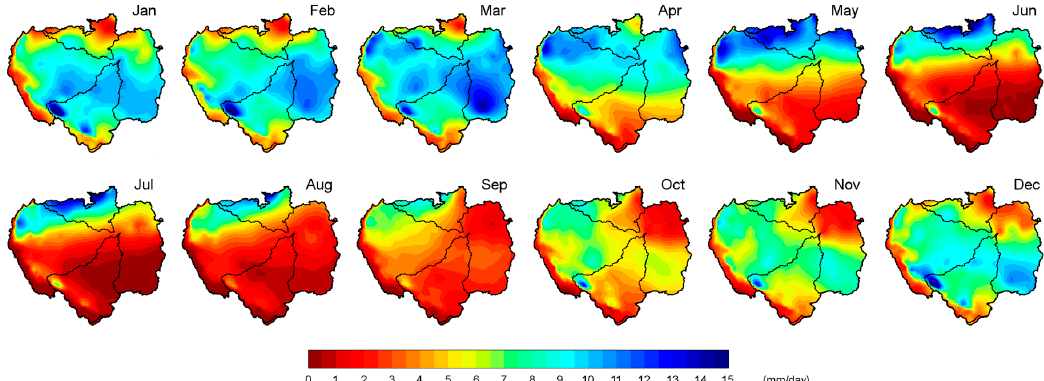
Figure 2. Monthly average precipitation (from CRU 3.2401) in the Amazon River basin (ARB). The Negro and Madeira River basin (NRB and MRB, respectively) boundaries are marked by contours. Period: 1980–2016.